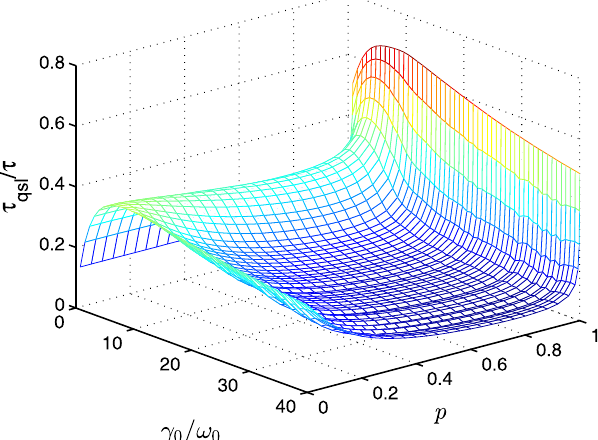
Figure 1. The ratio between the quantum speed limit time and actual driven time τ qsl / τ of qubit state (11) for damped Jaynes-Cumming model. The spectral width parameter is chosen as λ = 15 (in unit of ω 0 ), and the actual driving time is τ =